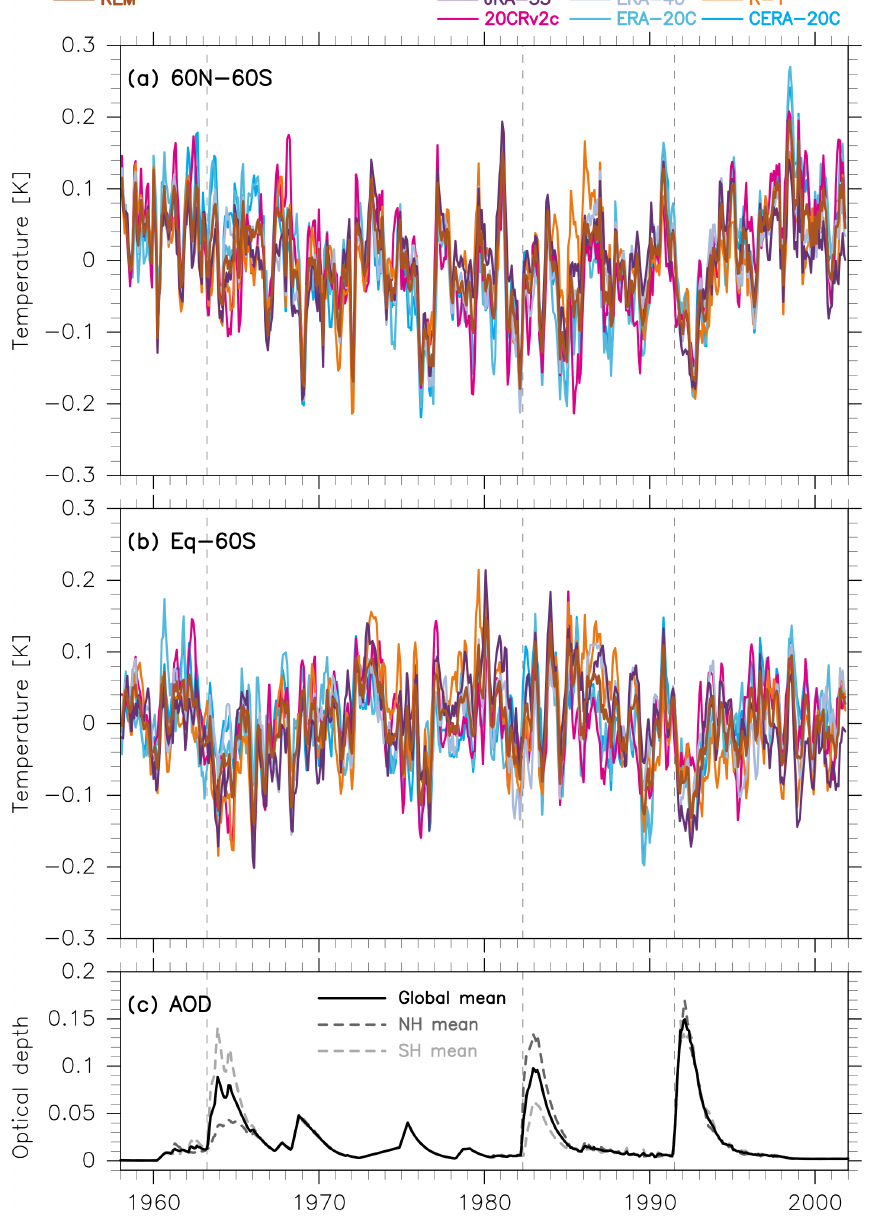
Figure 5. As for Fig. 1, but based on the 1958–2001 MLR analyses for six reanalysis data sets; averages for Equator–60 ◦ S are shown in panel (b) . For all panels, vertical dashed lines indicate the starting date of the three volcanic eruptions.